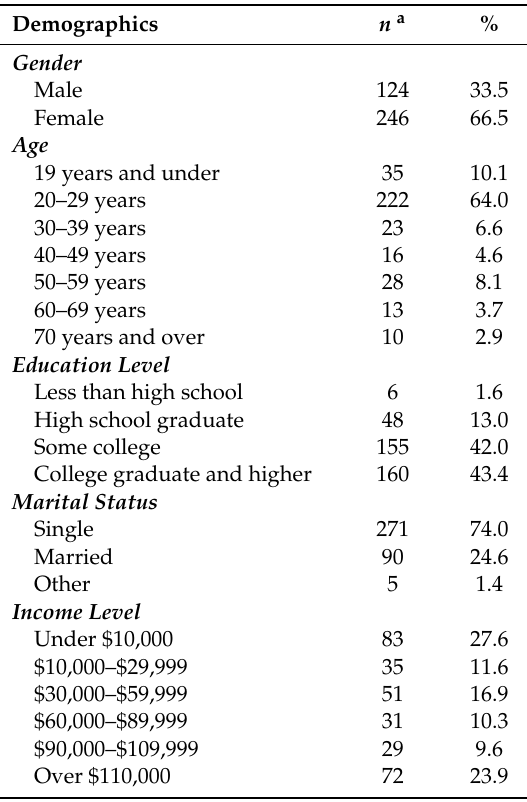
Table 1. Descriptive statistics of respondents ( n = 382).